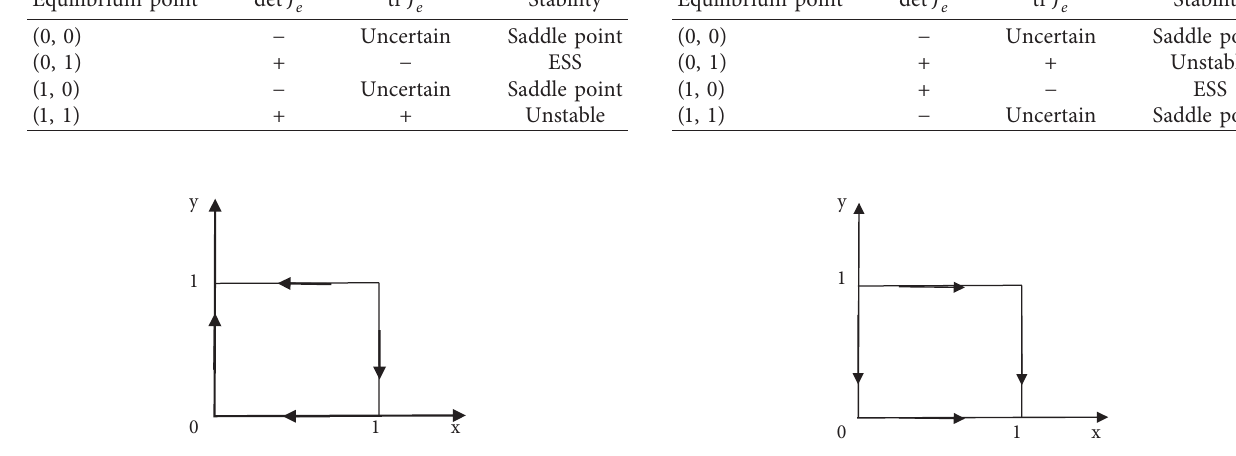
Figure 5: Game phase diagram when μ > α > ηβ and ε < ηβ − α <